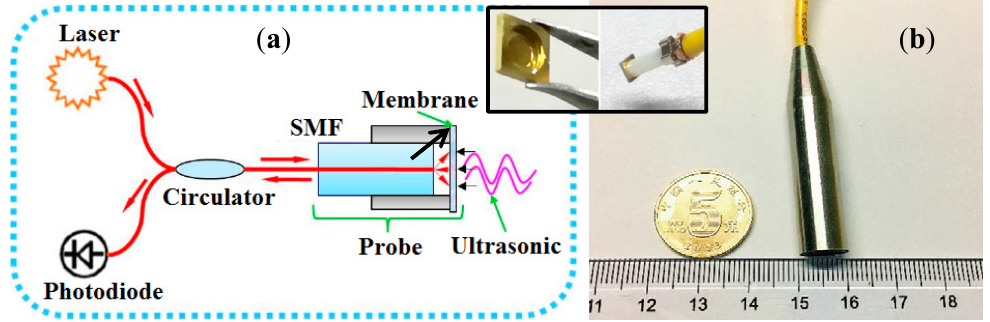
Figure 2. ( a ) Operational principle for detecting ultrasonic signals by utilizing the MEMS-on-fiber sensor. ( b ) Picture of a packaged sensing probe. SMF: single-mode fiber.